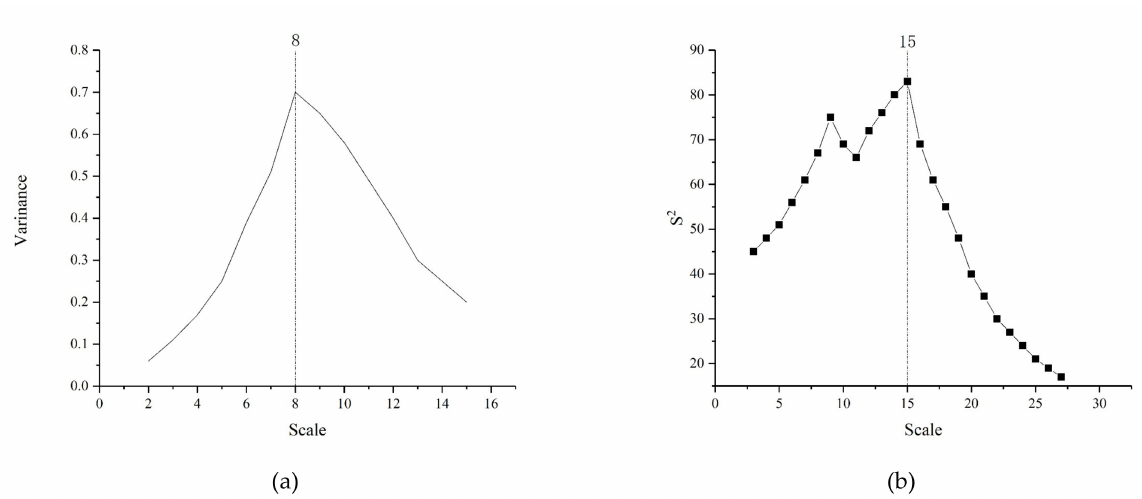
Figure 8. ( a ) Wavelet coefficient variance graph; ( b ) weighted average variance graph. The fusion image after wavelet transform is shown in Figure 9. It can be seen that compared with NTL images, the high values of NP (NTL_POI) images are still concentrated in Guangzhou, Foshan, Shenzhen, Hong Kong and Macao. However, compared with NTL images, the details of the fused NP images are more complete in the center and boundary.